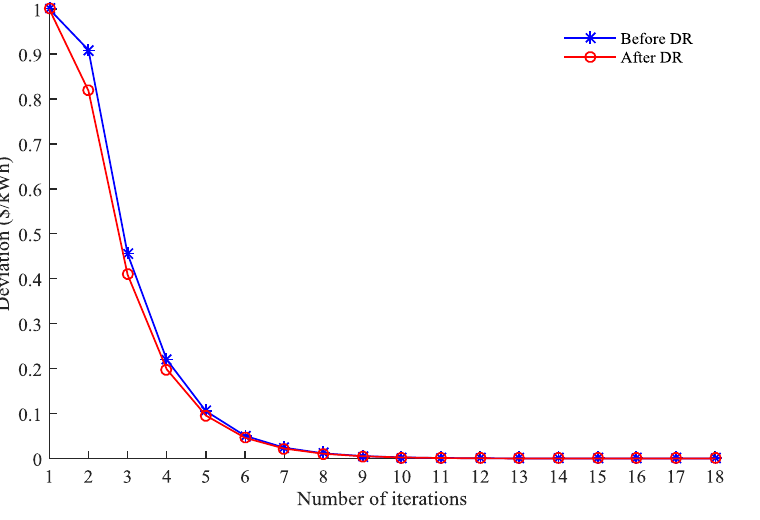
Figure 11. The convergence processes of payoffs of EHs and cost of EP.